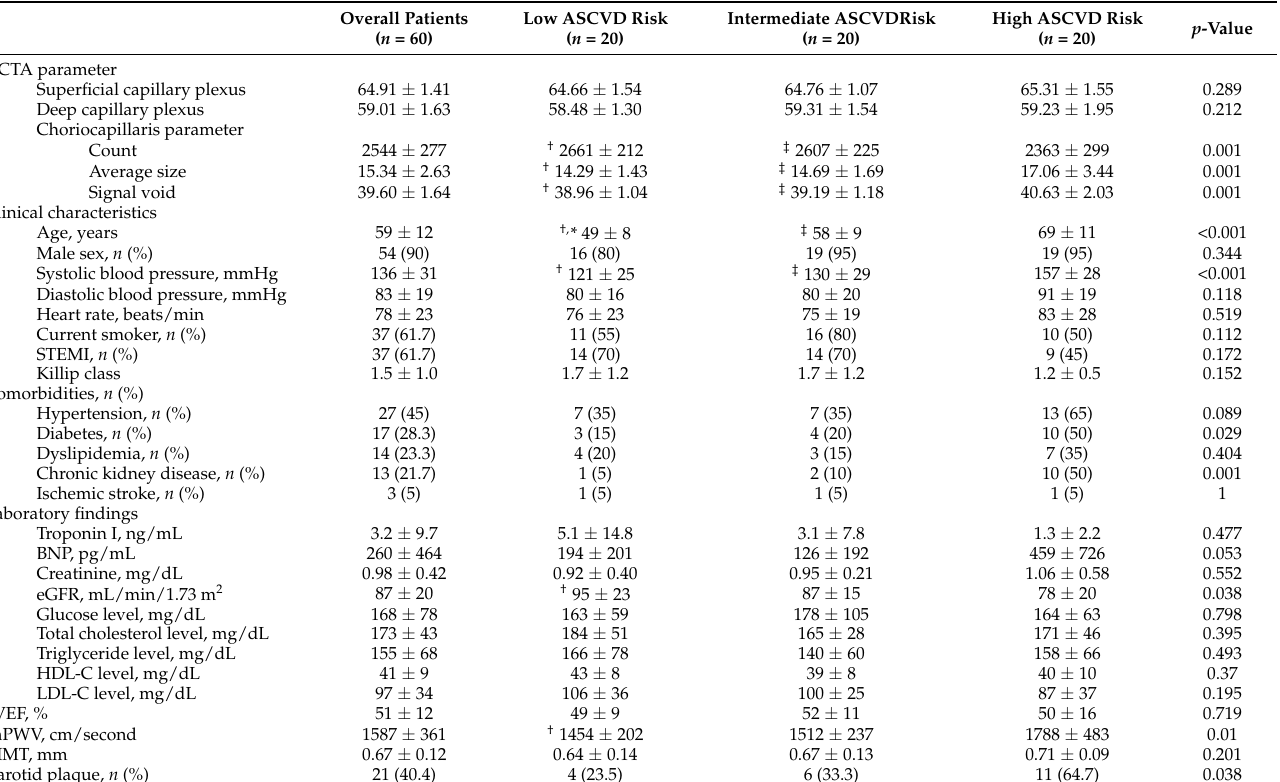
Table 1. Baseline characteristics, including OCTA parameters in the 3 groups according to the 10-year ASCVD risk.